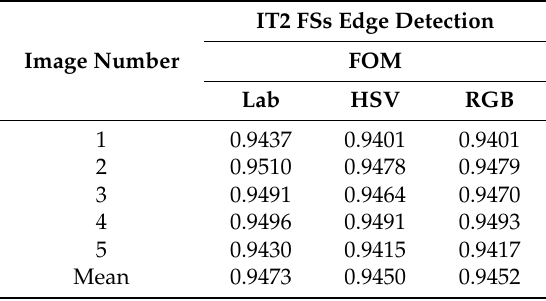
Table 4. IT2 FSs edge detection applied on Lab, HSV, and RGB images.